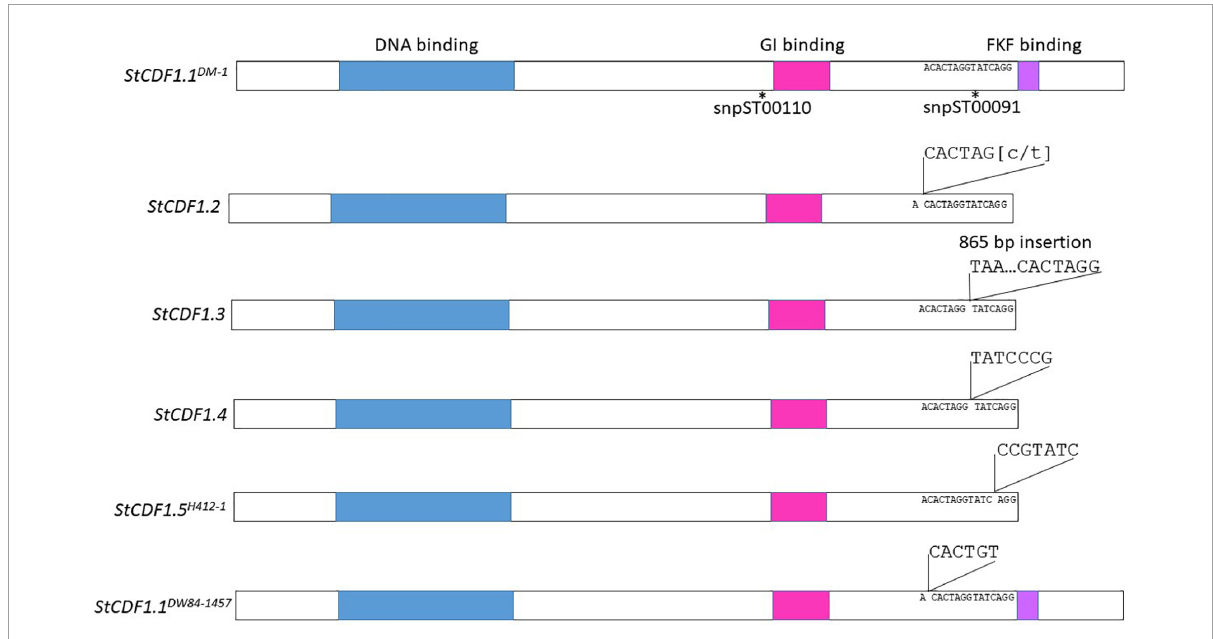
FIGURE7 Insertion mutations of StCDF1 alleles. The location of KASP TM markers snpST00110 and snpST00091 are shown. The DNA binding domain is indicated in blue, GI binding domain is pink and FKF binding domain is purple.